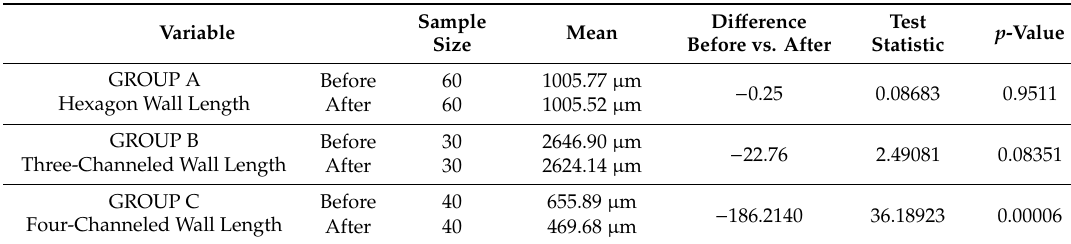
Table 3. Wall Length Deformations of Internal Connections. Statistical comparison for the three groups before and after implant insertion. p values are assigned for each comparison within groups. All the groups experimented changes at the wall length. The changes were significant at group C. Significance was set as p -value <